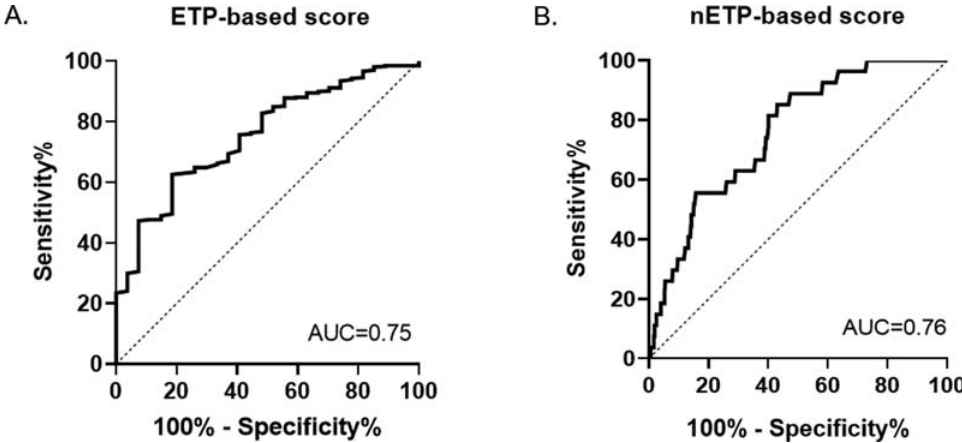
Fig. 3 Receiver operating characteristic curve analysis for ETP-based score ( A ) and nETP-based score ( B ). ETP, endogenous thrombin potential.